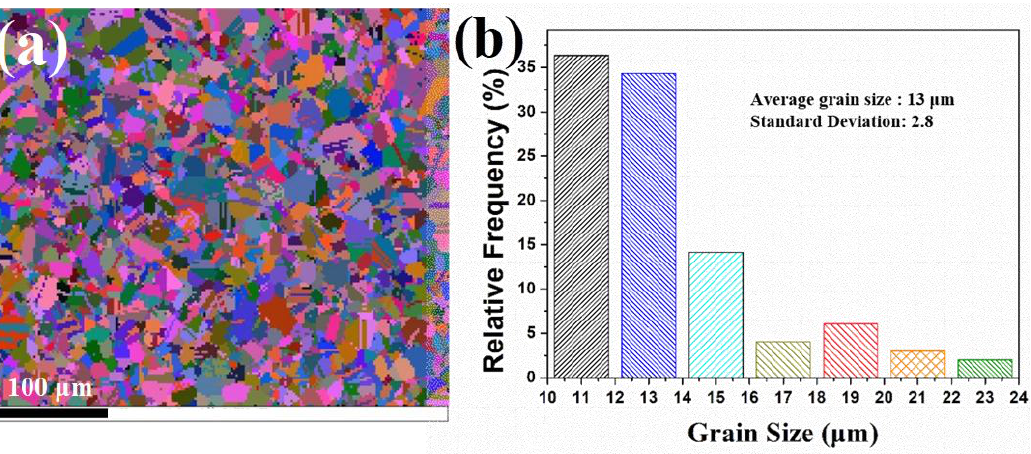
Figure 3. ( a ) Euler angle map after cooling to 1000 °C with a cooling rate of 6 °C /min. ( b ) The grain size distribution of ( a ).